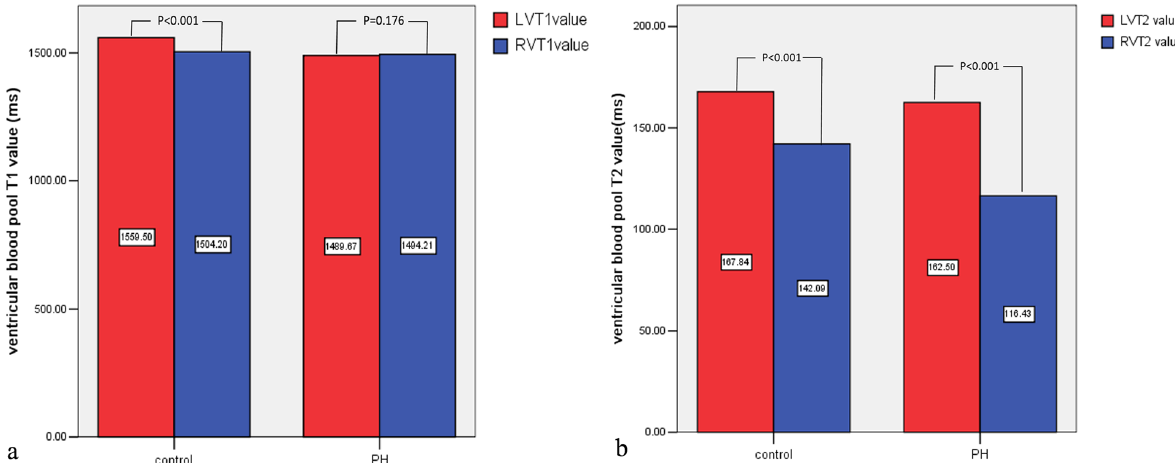
Fig. 5 Comparison of ventricular blood pool T1 and T2 in healthy volunteers and PH patients. a LVT1 is higher than RVT1 in healthy volunteers and LVT1 is comparable to RVT1 in PH patients. b LVT2 is higher than RVT2 in healthy volunteers and PH